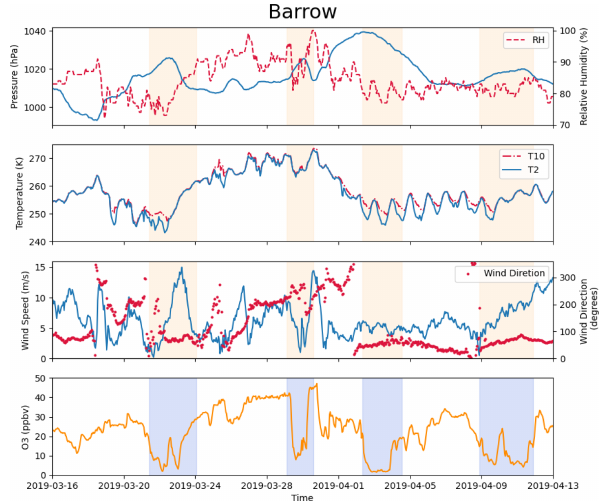
Figure 2. Measurements of pressure, relative humidity, tempera- ture at 2 and 10m, wind direction, wind speed at 10m, and sur- face ozone at Barrow (now known as Utqia˙gvik) from 16 March to 13 April 2019. The shaded areas denote the occurrence of complete ODEs, the minimum ozone of which is less than